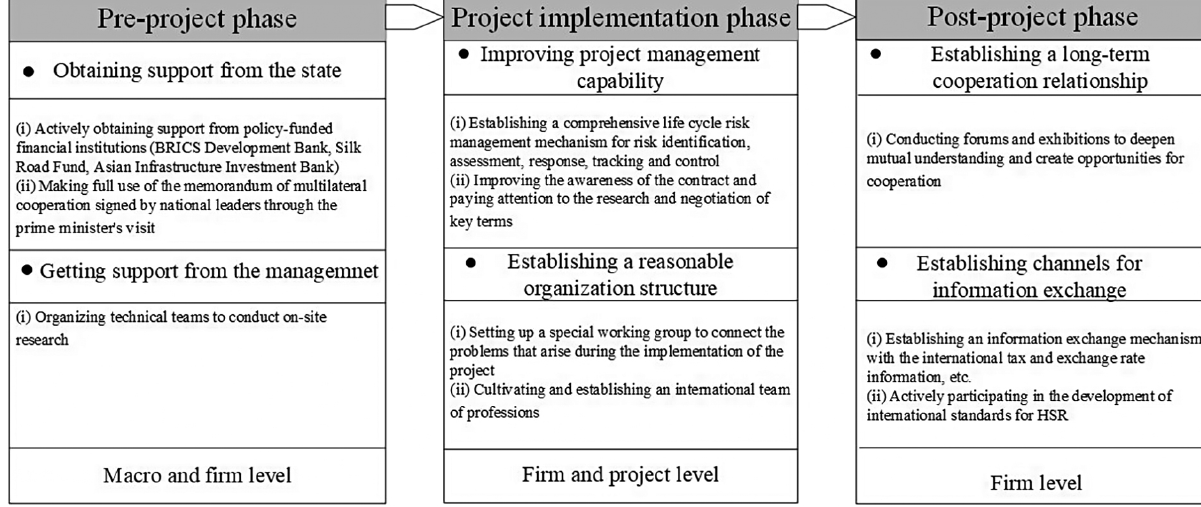
Figure 5. Measures at different project